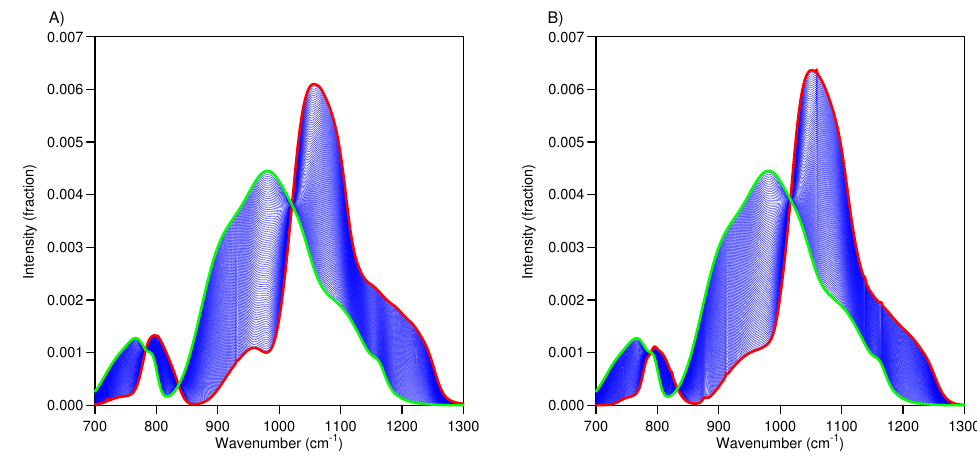
Fig. 2. Mass-balance models for the BFC mod -“Silt” (A) and PS1772-8-“Silt” (B) end-members. Red and green lines show the baseline corrected FTIR spectra for the pure diatom and “Silt” end-members respectively. Blue lines show the expected modelled spectra for samples containing different proportions of diatoms/contaminants. Samples containing 100% diatoms/contaminants are expected to plot on the diatom/“Silt” end-member spectra respectively. As the proportion of diatoms in the sample decreases, sample FTIR spectra are expected to progressively plot away from the red, pure diatom, spectra towards the green, pure “Silt”, spectra.